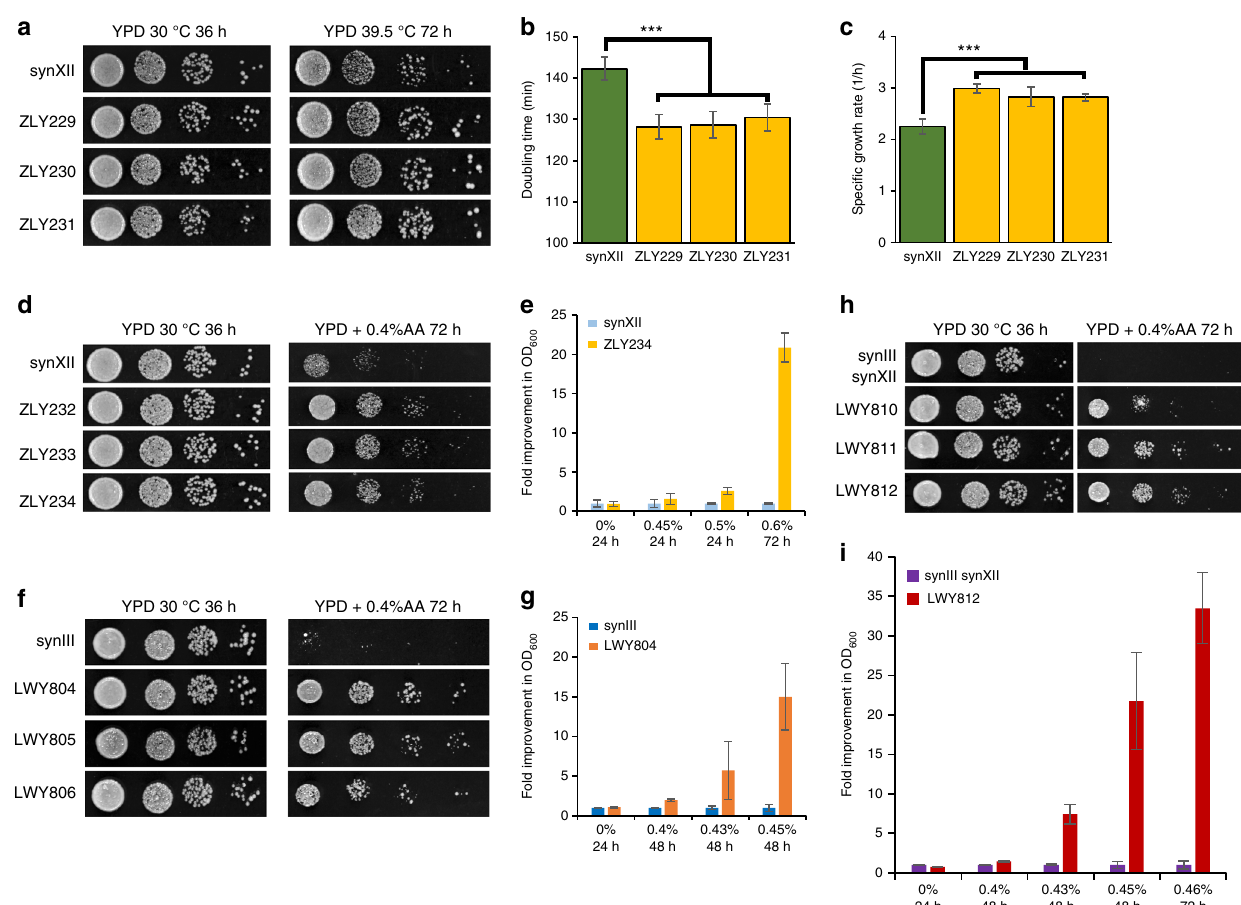
Fig. 5 Rapid strain improvement by ReSCuES and SCRaMbLE. ReSCuES was applied to identify SCRaMbLEd strains, which are more resistant to higher temperature or acetic acid in strains containing synXII, synIII, or both. Three resistant clones were randomly isolated and tested. a SCRaMbLEd synXII strains were more resistant to high temperature as tested by 10× serial dilution. b Doubling time (mean ± s.d.) of synXII and the SCRaMbLEd strains in YPD medium under 39.5°C. Three biological replicates were measured, *** is for a P -value < 0.01 using two-tailed student t -test. c Speci fi c growth rate (h − 1 ) (mean ± s.d.) was calculated for synXII and the SCRaMbLEd strains in YPD medium under 39.5 °C. Three biological replicates were measured, *** is for a P -value < 0.01 using two-tailed student t -test. d SCRaMbLEd synXII strains were more resistant to acetic acid (AA) as tested by 10× serial dilution. e The growth capacity of ZLY234 was compared to that of the original synXII strain under different level of stress (0% – 0.6% acetic acid, V/V%). Three biological replicates were tested for each strain, using an initial OD 600 = 0.01. The cell density at each time point and acetic acid concentration was normalized to the original synXII strain (mean ± s.d.). f SCRaMbLEd synIII strains were more resistant to AA as tested by 10× serial dilution. g The growth capacity of LWY804 was compared to that of the original synIII strain under different level of stress (0% – 0.45% acetic acid, V/V%). The experiment was performed the same as e . h SCRaMbLEd synIII,synXII strains were more resistant to AA as tested by 10× serial dilution. i The growth of LWY812 was compared to that of